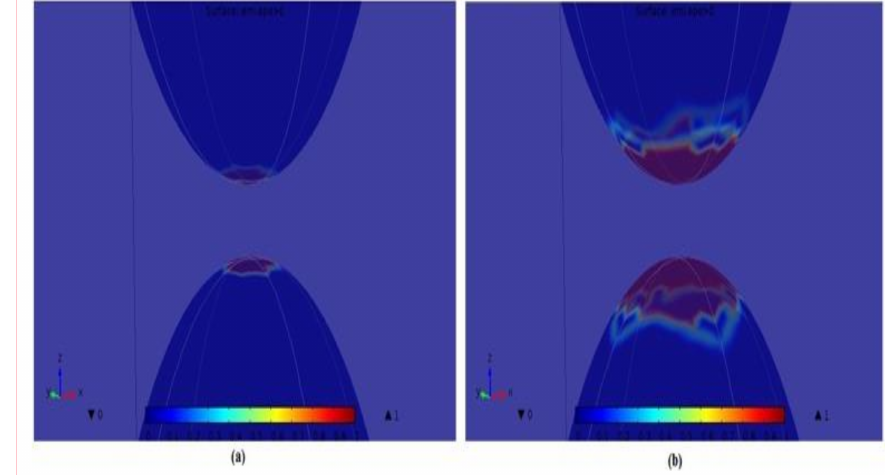
Figure 19. Increase in the plasticized region with electric field: ( a ) 150 kV / mm; ( b ) 250 kV / mm. (Note: distance between points B and C is held fixed at 1000 nm).